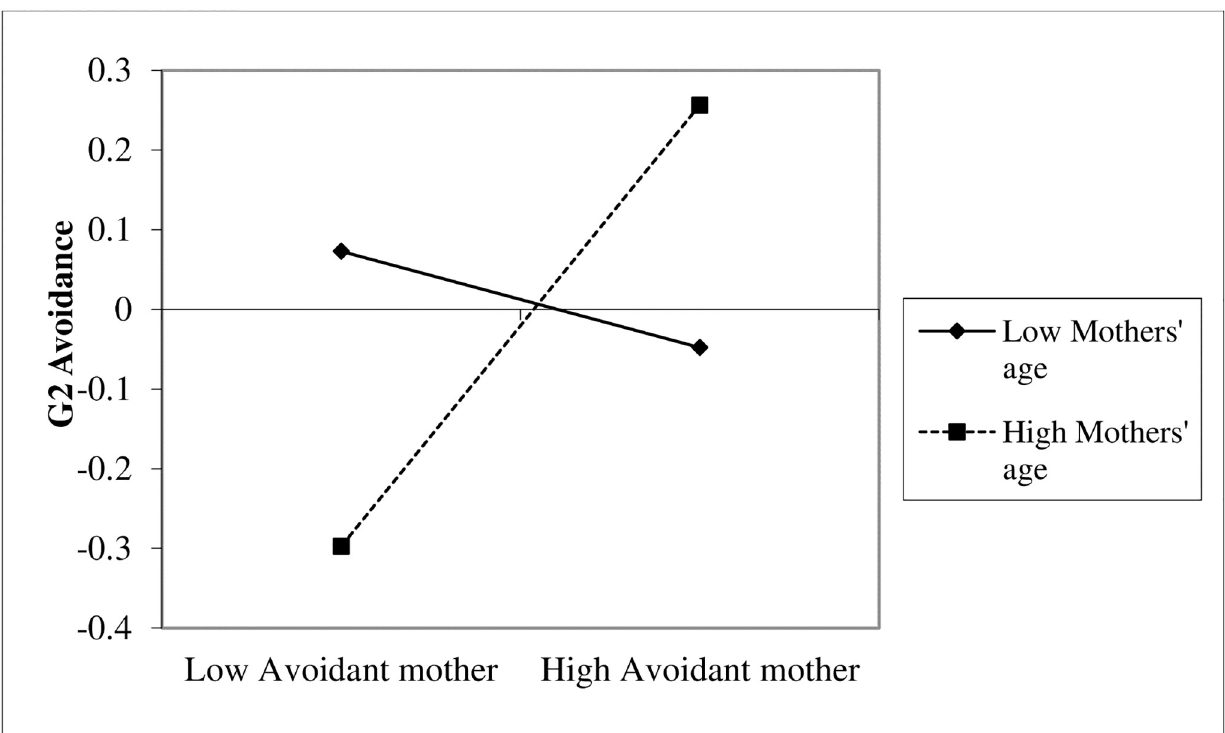
Fig 3. G1 mothers’ avoidance effects on G2 avoidance for low and high mothers’